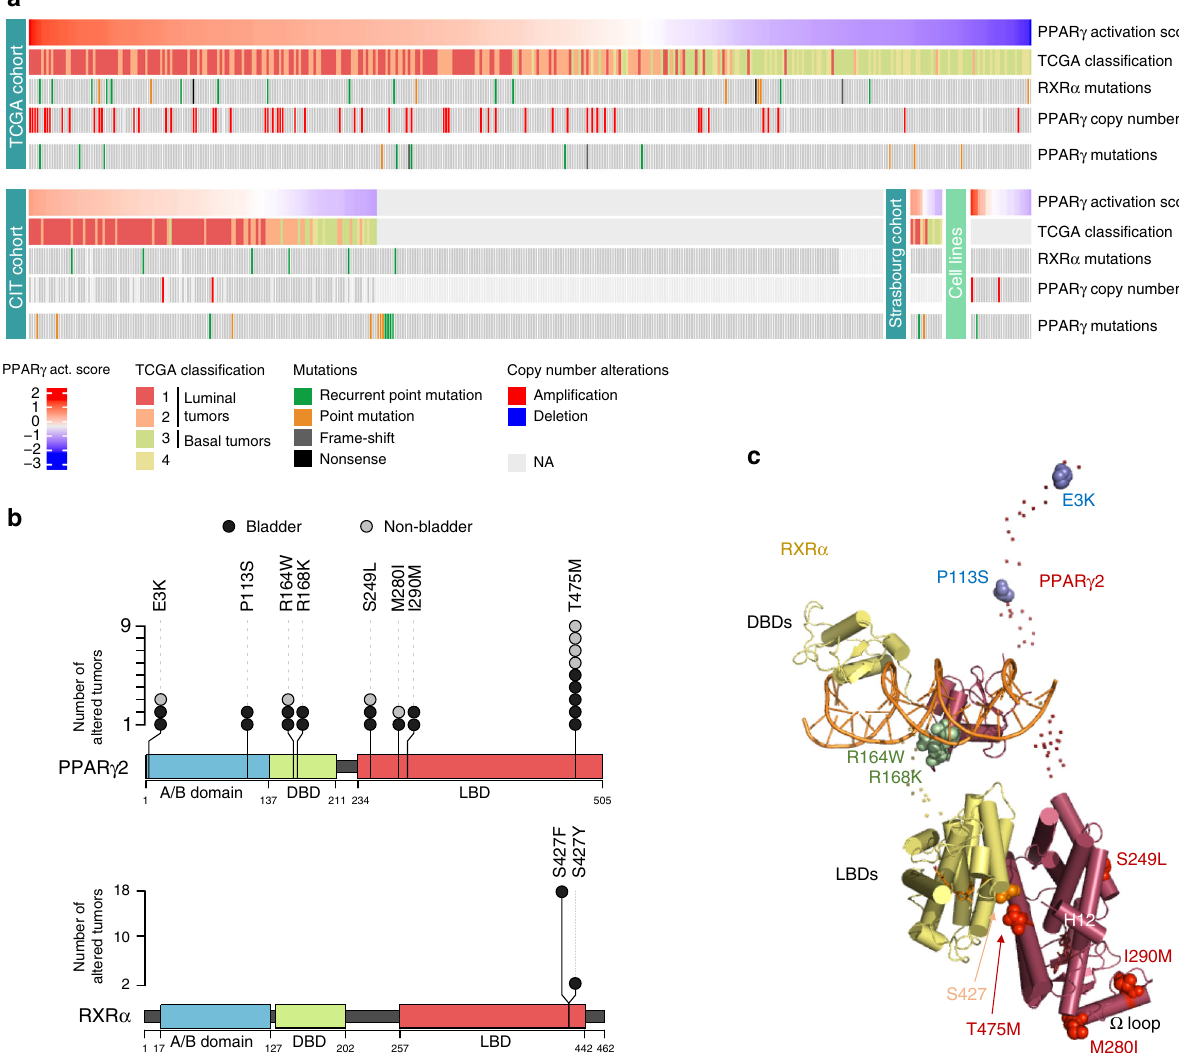
Fig. 1 Mutations of PPAR γ and RXR α in bladder tumors. a Oncoprints of PPAR γ and RXR α mutations in three series of bladder tumors and a panel of 25 bladder tumor cell lines. Samples were sorted by PPAR γ activation score when transcriptomic data were available. Source data are provided as a Source Data fi le. b Lolliplot representations of recurrent mutations of PPAR γ (upper panel) and RXR α (lower panel) identi fi ed in the 859 bladder tumors studied here (black circles) or in publicly available data available for other bladder tumors and other types of cancer from the COSMIC and cBioPortal databases (Supplementary Table 4) (gray circles). Sequences are numbered according to the PPAR γ 2 isoform. A/B: N-terminal domain; DBD: DNA-binding domain; LBD: ligand-binding domain (LBD). c Position of the residues affected by the recurrent PPAR γ and RXR α mutations on the full-length PPAR γ -RXR α -DNA- coactivator peptide solution structure 51 . The folded domains are shown in cartoon representation and the disordered hinges and NTDs are shown as dots. The mutated residues are shown as spheres. The residues mutated in PPAR γ are colored in blue (A/B domain), green (DBD), and red (LBD). The residue mutated in RXR α is colored in orange. Source data are provided as a Source Data fi